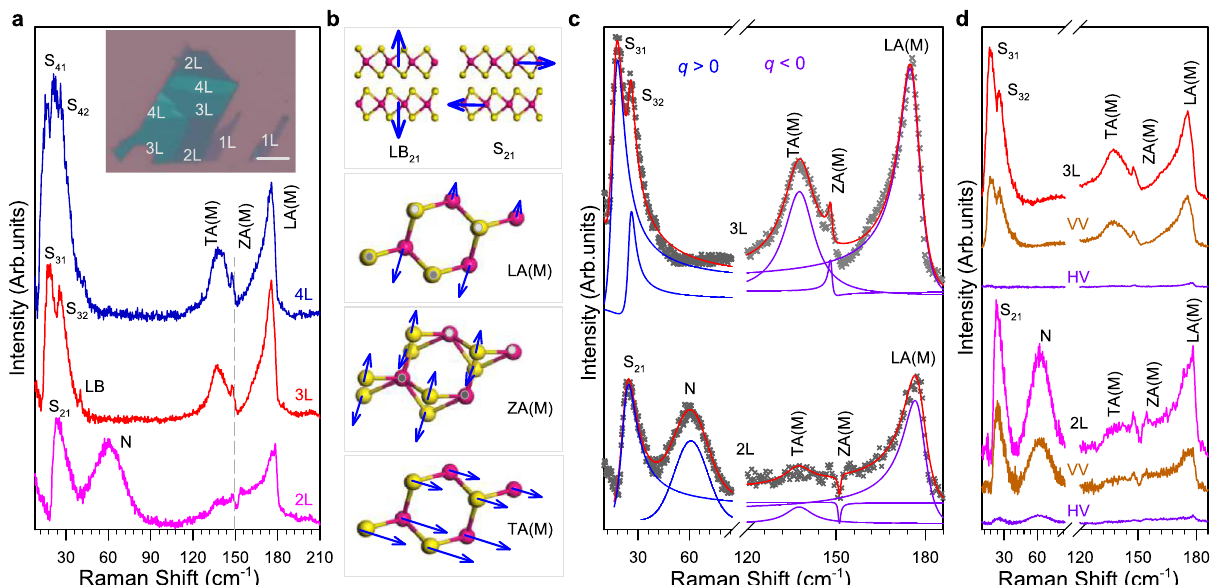
Fig. 2 | Observationofquantum interference in few-layerWS 2 . a Ramanspectra of 2-4L WS 2 at 4 K. Shear and layer breathing modes are labeled as S mi and LB mi , where m and i representlayernumbersandthe i thmodes,respectively 46 .Ndenotes a new peak. The inset shows the optical microscopy image of the few-layer WS 2 sample (S1). The scale bar is 10 μ m. b Illustration of the vibration of the layer breathing (LB 21 ),shear(S 21 ) modes of 2L-WS 2 and TA(M),ZA(M),and LA(M)modes